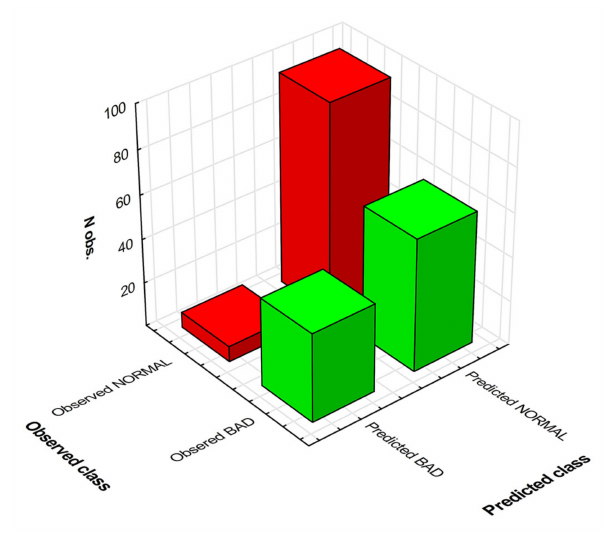
Figure 11. Classification matrix for the classification tree (2Q).